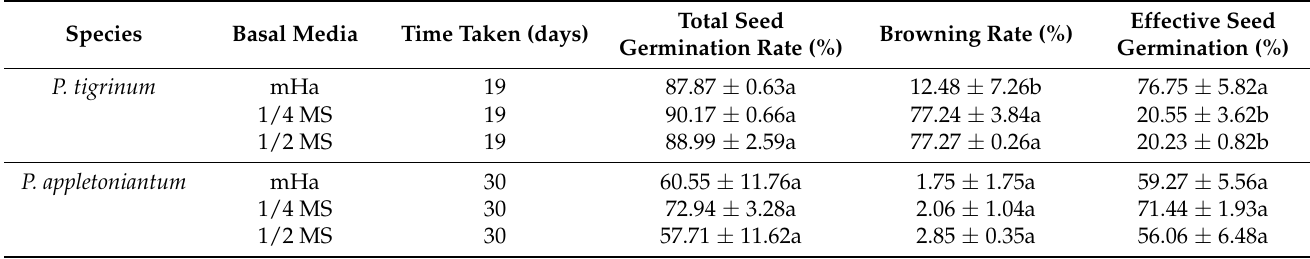
Table 1. Effect of basal medium on seed germination of Paphiopedilum tigrinum and P. appletoniantum . Species Basal Media Time Taken (days)